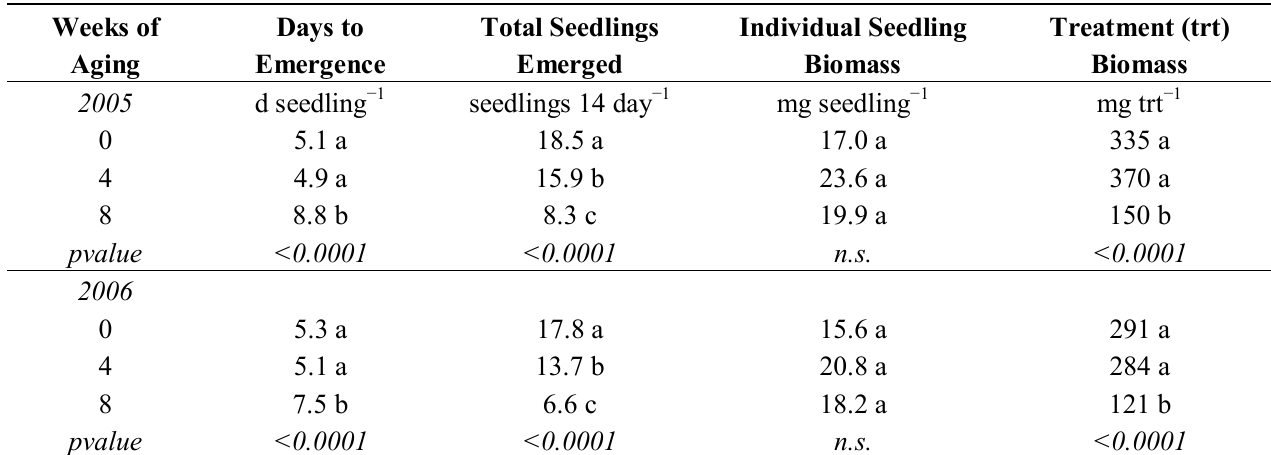
Table 2. Mean values for seed vigor variables for the SH430 seed from the 2005 and 2006 grow